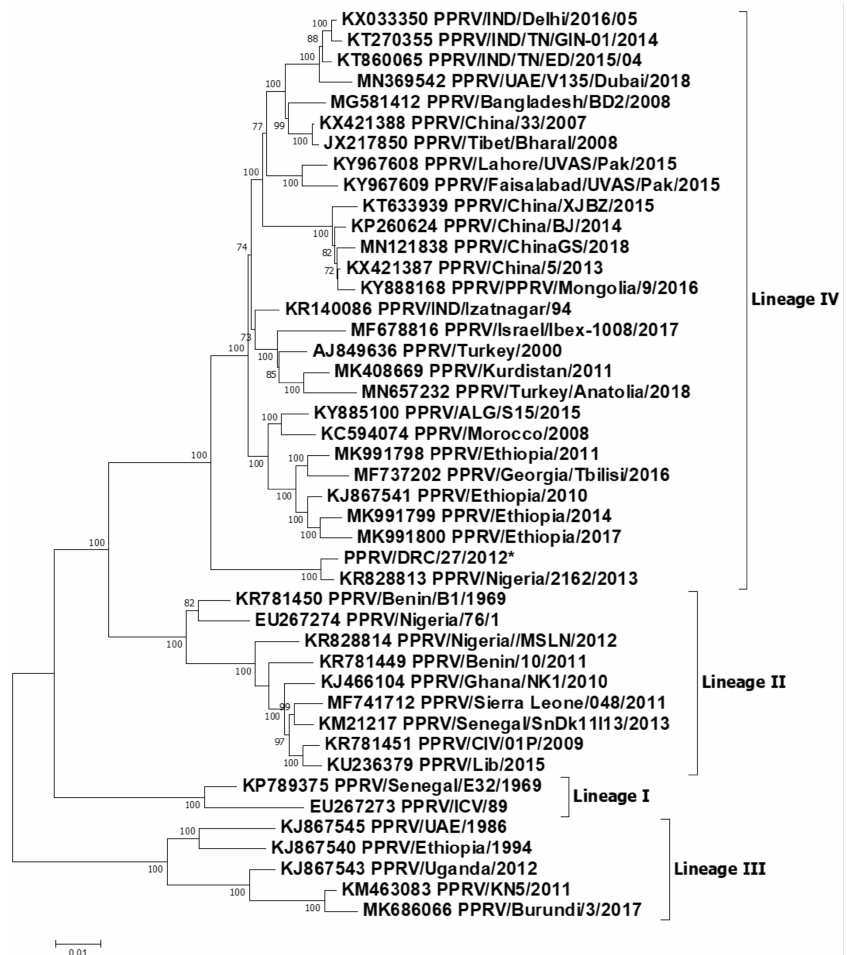
Figure 3. Neighbor-joining tree constructed using full genome sequences of peste des petits ruminants virus (PPRV), showing relationships among the PPRV isolates. The Kimura 2-parameter model was used to calculate percentages (indicated by numbers beside branches) of replicate trees in which the associated taxa clustered together in 1000 bootstrap replicates. The sequence from the DRC generated in this study (accession number PPRV/DRC/Tshela/27/2012-OL310685) is indicated by a star. Scale bar indicates nucleotide substitutions per